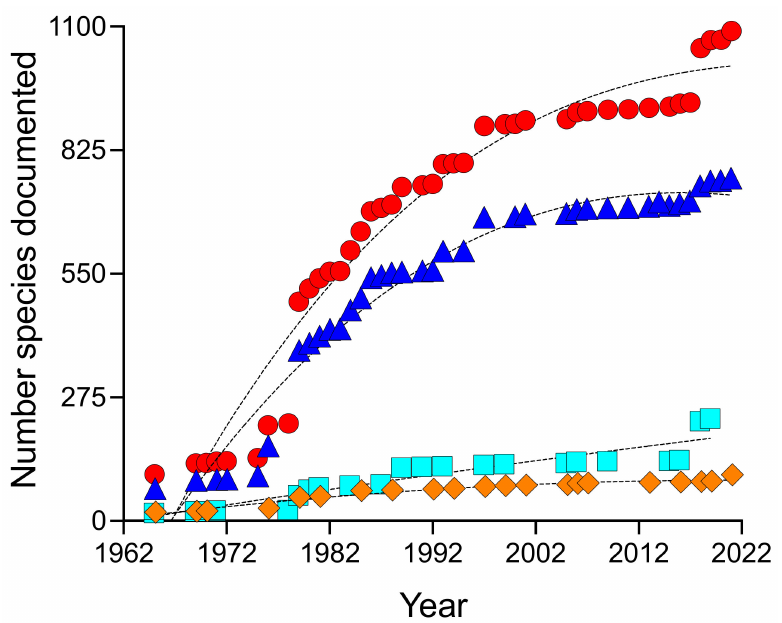
Figure 2. Species-accumulation curve for bony and cartilaginous fishes (diamonds), macroalgae and seagrasses (squares), invertebrates (triangles), as well as all marine taxa (circles) documented from seven different reef sites in Blue Cavern Onshore SMCA from 1965 to 2022.